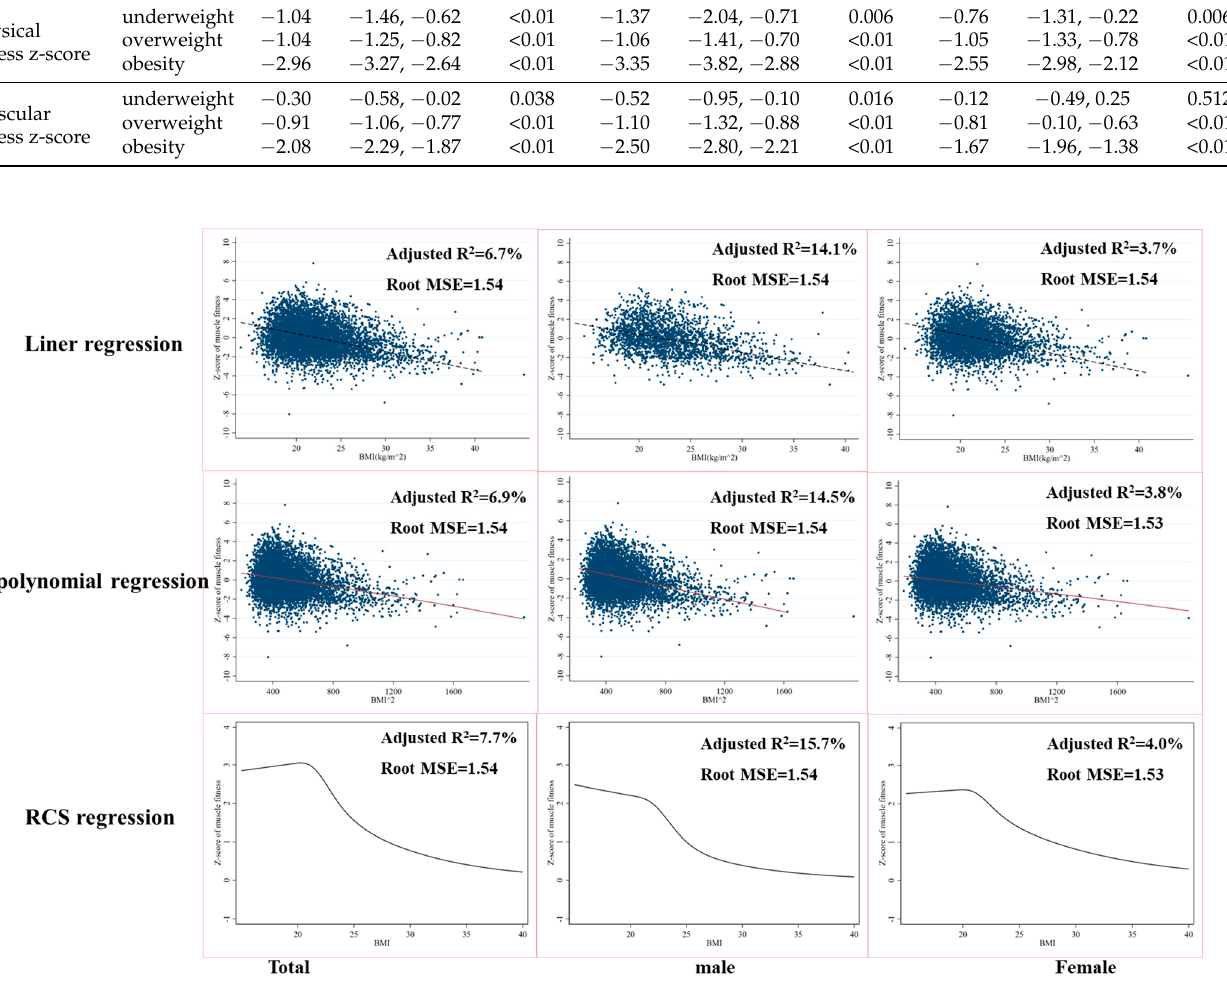
Figure 2. Linear regression, polynomial regression, and restricted cubic spines (RCS) analysis for BMI values and muscular fitness z-score in college freshmen. BMI values and muscular fitness z-score in college